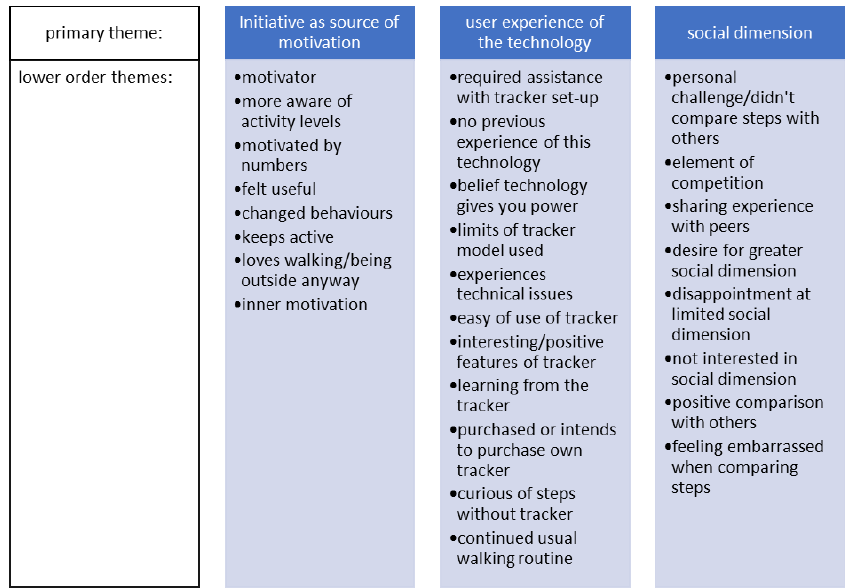
Figure A1. Coding Tree.